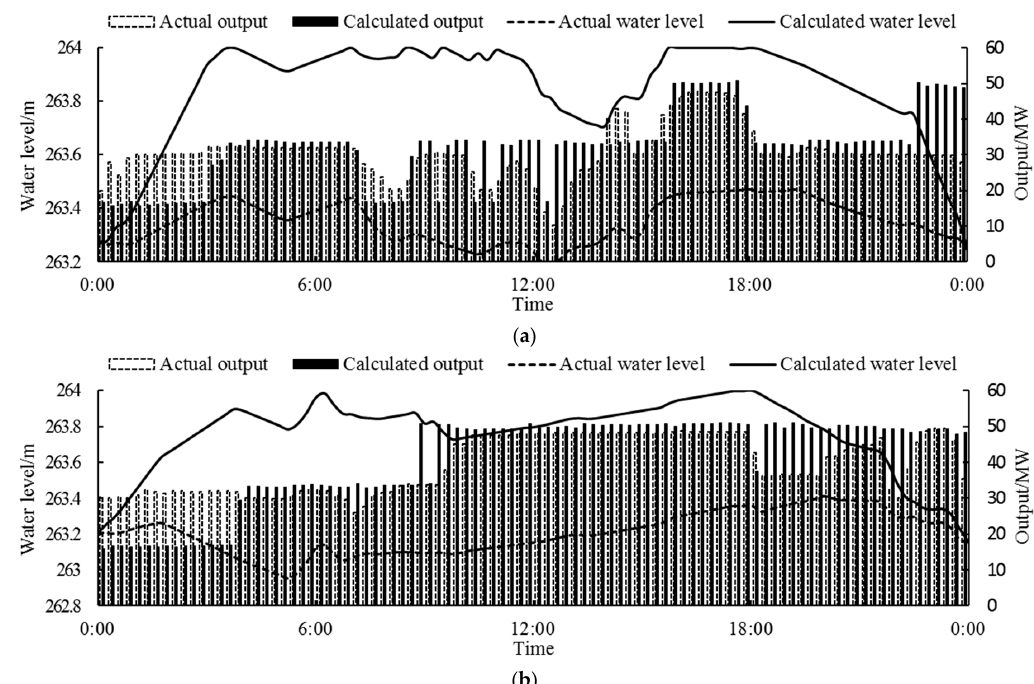
Figure 11. Comparison between optimal and actual operation schemes of Xiaoxuan, ( a ) 1 July; ( b ) 12 June.